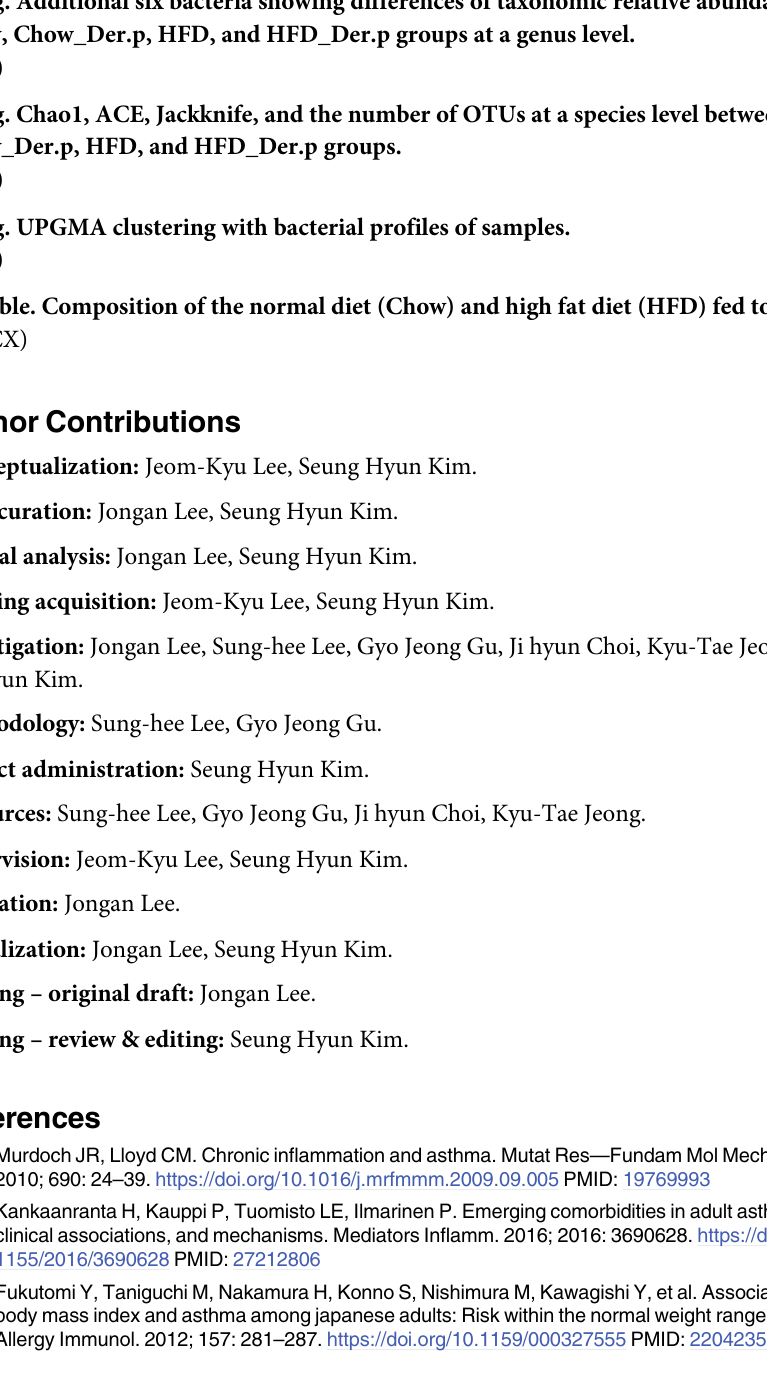
S1 Fig. Lung histopathology and proportions of macrophage phenotypes of lung tissues. (TIF) S2 Fig. Additional six bacteria showing differences of taxonomic relative abundances in Chow, Chow_Der.p, HFD, and HFD_Der.p groups at a genus level. (PDF) S3 Fig. Chao1, ACE, Jackknife, and the number of OTUs at a species level between Chow, Chow_Der.p, HFD, and HFD_Der.p groups. S4 Fig. UPGMA clustering with bacterial profiles of samples. S1 Table. Composition of the normal diet (Chow) and high fat diet (HFD) fed to